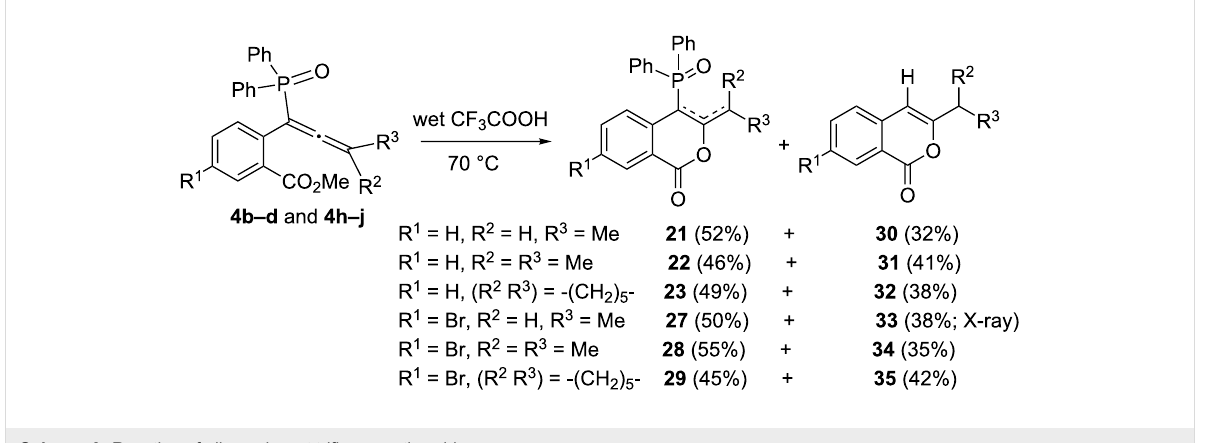
Scheme 9: Reaction of allenes in wet trifluoroacetic